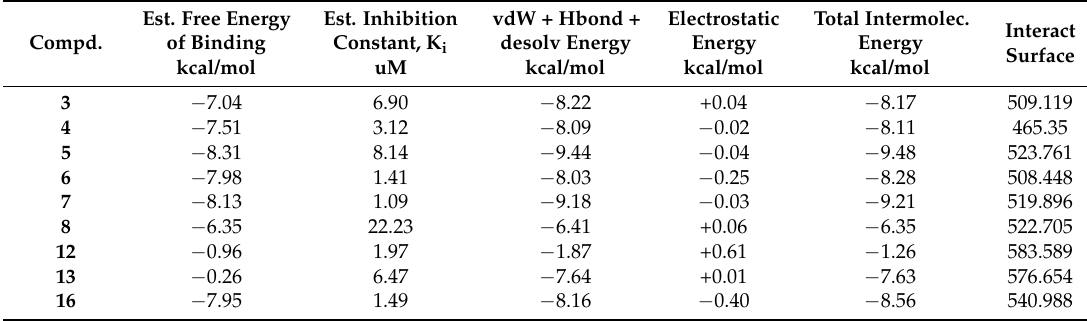
Table 2. Energy values obtained in docking calculations of some synthesized compounds with receptor prostate cancer (2q7k).